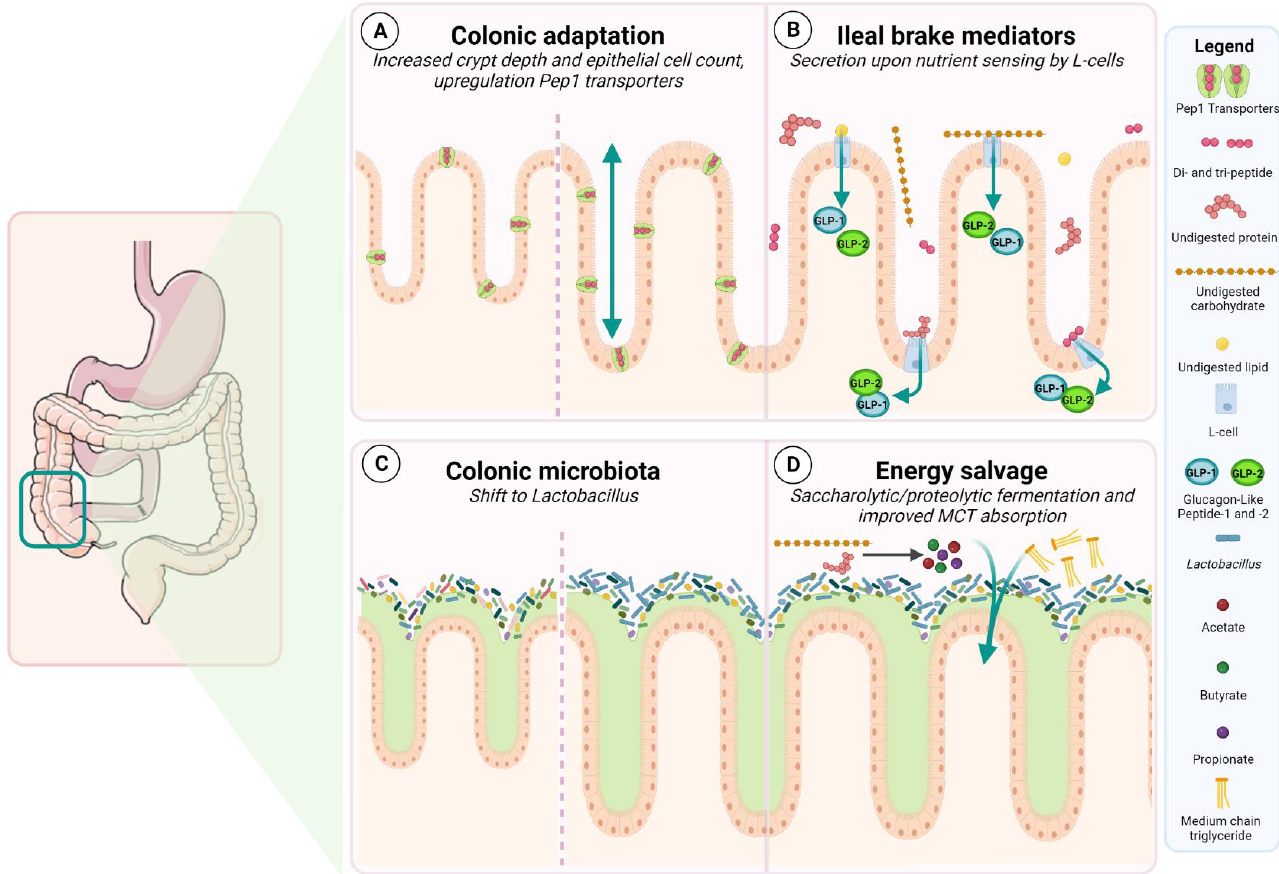
Figure 3. Physiological changes of a preserved colon in continuity in Short Bowel Syndrome with Intestinal Failure. ( A ) Increases in crypt depth and epithelial cell count, and an upregulation of Pep1 transporters are part of the colonic adaptation that takes place within the first two years after exten- sive surgery. ( B ) L-cells located in the distal ileum and proximal colon secrete GLP-1 and GLP-2 based on nutrient entry in the gut lumen. Both are mediators of the ileal brake and expression is increased when the colon is in continuity. ( C ) Qualitative and quantitative changes of the microbial flora take place when the colon is in continuity: the colonic microbiota of patients with SBS is mainly comprised of Lactobacillus . ( D ) The colon serves as an energy-salvaging organ: high levels of undi- gested carbohydrates and proteins will reach the colon and will be fermented by the microbiota resulting in SCFA production. In addition, MCT absorption is improved. This figure was created with BioRender.com. Next to the increased absorptive area, structural adaptation also comprises bowel dilatation and lengthening, increased angiogenesis, and increased apoptosis. The func- tional adaptation is based on a deceleration of the accelerated gastrointestinal transit and alterations in epithelial transporters. To date, evidence on these features and their contri- bution to human intestinal adaptation after resection remains limited and is mainly based on animal studies (recently reviewed in [3]). 2.2. The Role of Food Intake and Hyperphagia Intestinal absorption and adaptation can be promoted by food intake, both orally and enterally, which improves patient outcomes and reduces the need for PS. Research from Joly et al. showed that continuous enteral feeding in the post-resection setting, either com- bined with or without oral intake, led to a significant increase in the net absorption of lipids, proteins, and energy compared to oral intake alone [26]. However, oral food intake should also be encouraged. Indeed, hyperphagia, a clinical manifestation that is usually